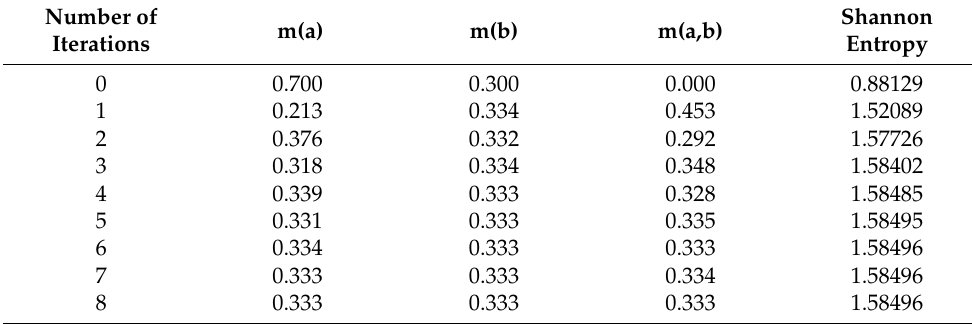
Table 2. BPA and entropy after logarithmic negation iterations in Example 2.